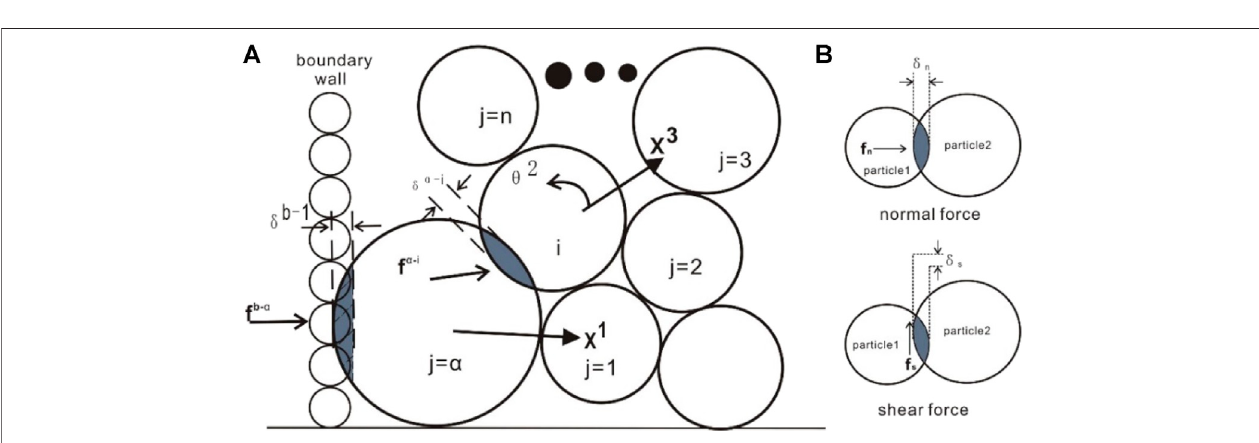
FIGURE4| SchematicdiagramofparticleinteractionsinDEM. (A) theinteractionbetweentheboundarywallandparticlesofstrata,whichcauseparticlestomove, rotating by overlapping with each other under the role of self-gravity and external stress transmitted from the moving boundary wall; (B) two forces (normal force and shear force) during the interaction between two